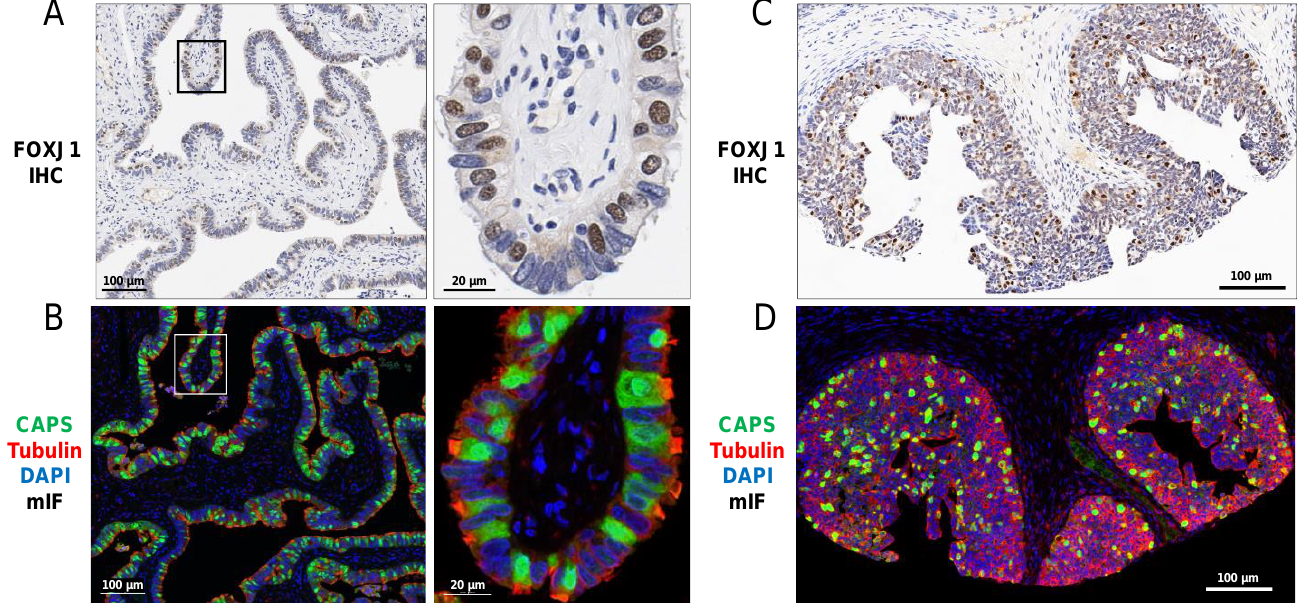
Figure 1. Ciliated cell markers FOXJ1 (IHC) and CAPS (mIF) in ( A , B ) normal fallopian tube and ( C , D ) proliferative endometrium. FOXJ1 shows nuclear staining ( A , C ) while CAPS shows diffuse intracellular staining ( B , D ). TUBB4 stains the cytoskeleton including base of cilia ( B , D ). Images (left) are shown at higher magnification (right). ( A , C ) Hematoxylin counterstain. ( B , D ) DAPI counterstain.